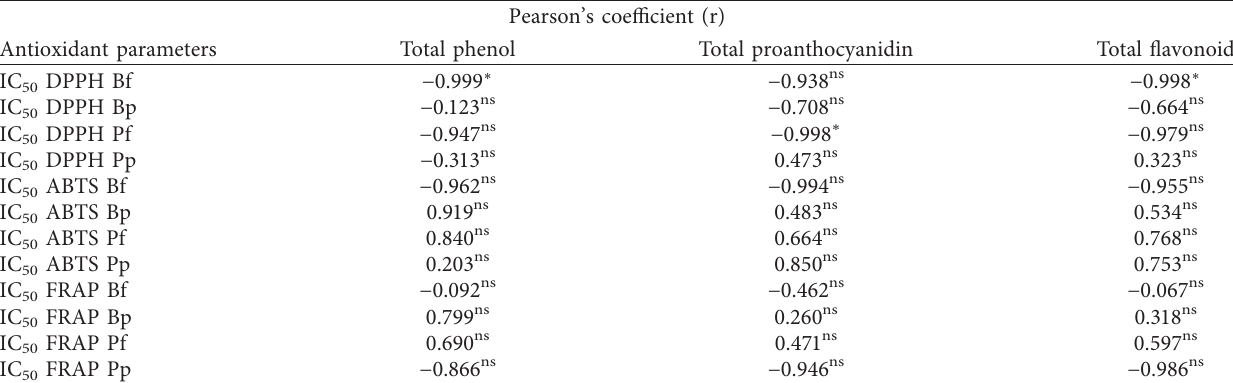
Table 7: Correlation between phytochemical constituents and antioxidant activity of M. sinensis and M. paradisiaca flesh and peel